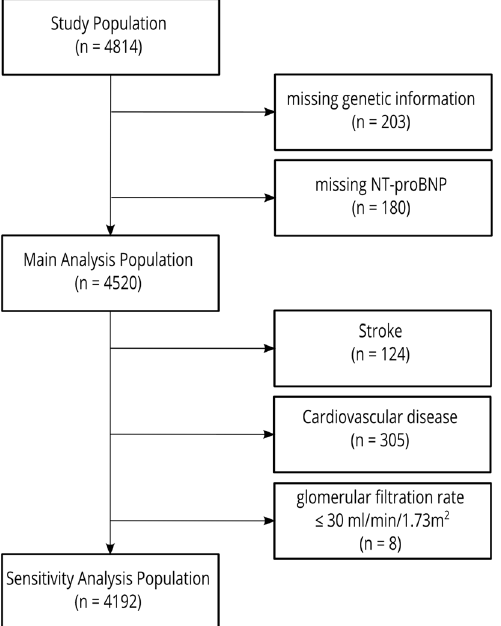
Figure 1. Flow-chart of participants of the Heinz Nixdorf Recall Study included in the